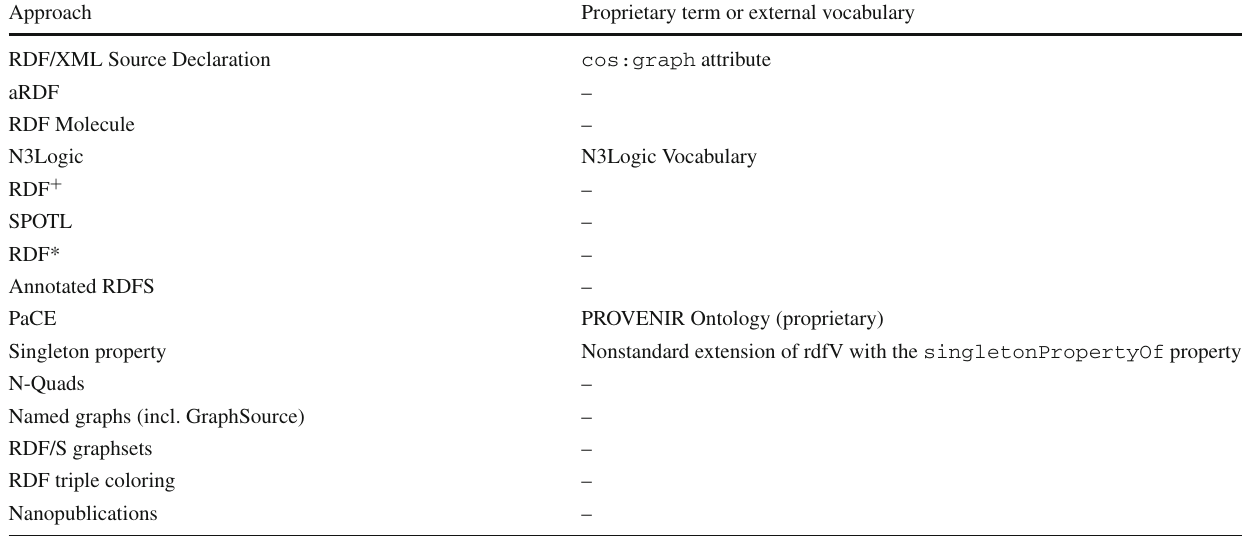
Table 6 Some approaches rely on a single term or an entire ontology to capture